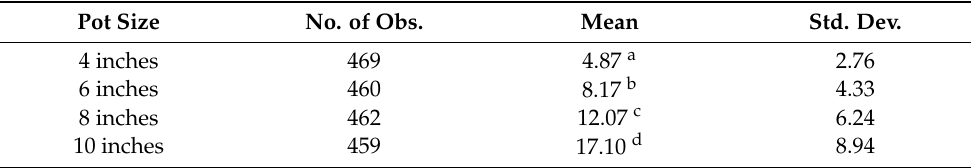
Means denoted by a different letter indicate significant differences between pot sizes ( p ≤ 0.05).